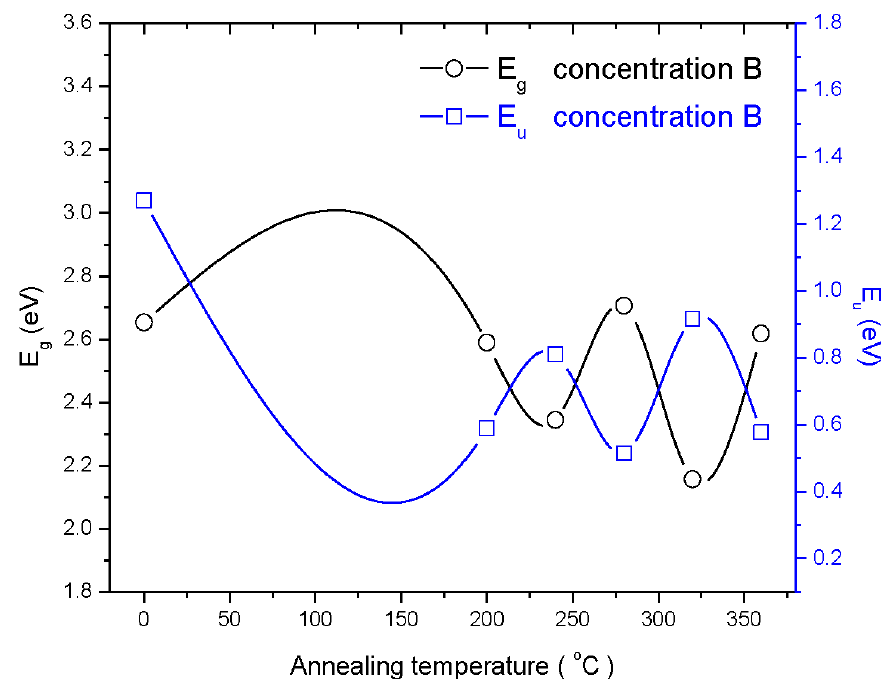
Figure 10. Variation of the optical energy band gap ( E annealing temperature for concentration